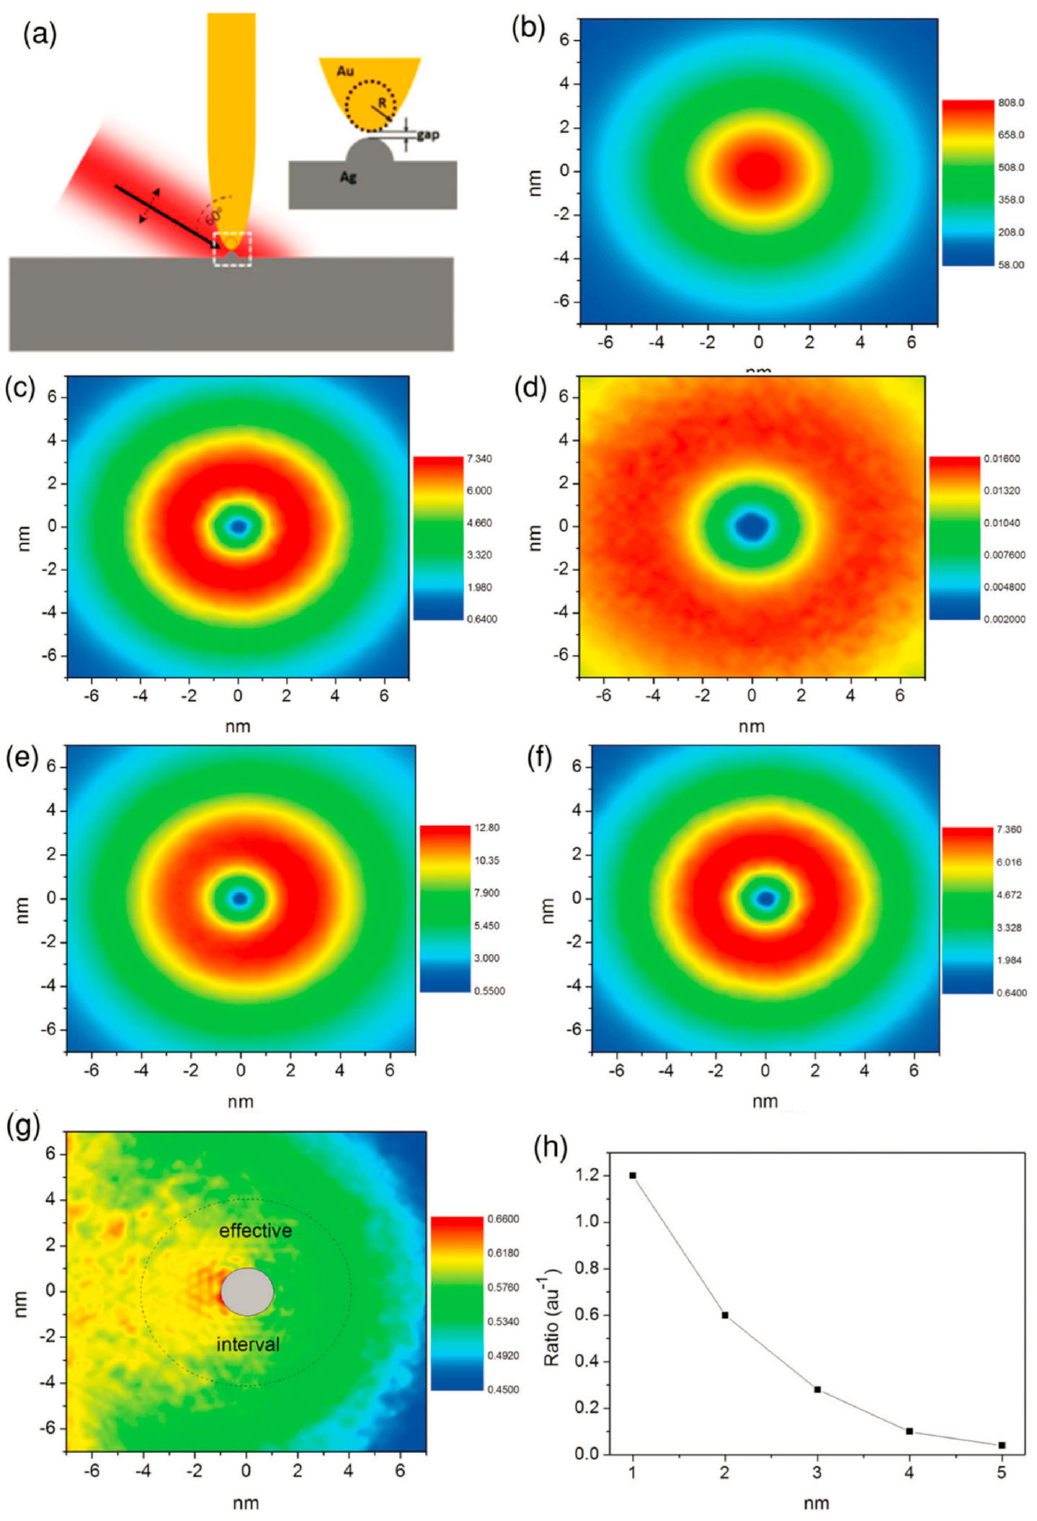
Figure 3. ( a ) The diagram of TERS system, ( b ) the stimulated electric field intensity at the center, ( c ) the stimulated electric field gradient intensity along tip axis ( d ) the ratio between electric field gradient and electric field intensity, ( e ) the stimulated electric field intensity along the substrate, ( f ) the stimulated electric field gradient intensity along the substrate, ( g ) the ratio between electric field gradient and electric field and ( h ) the distance dependent ratio